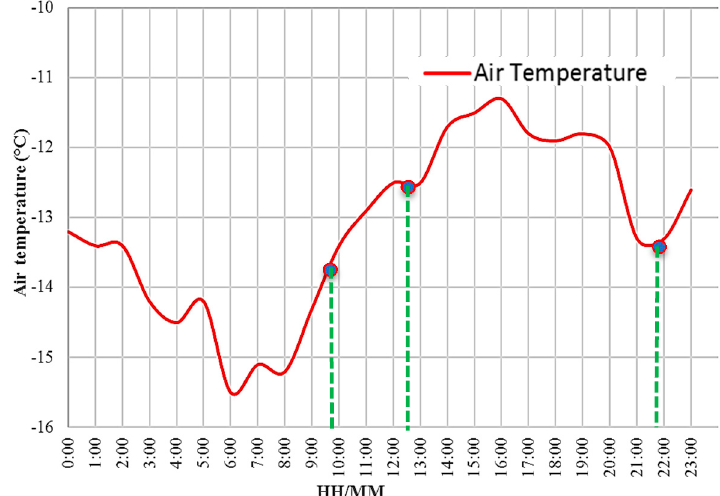
Figure 2. Hourly air temperature measured on 19 May 2012, from the on-ice micro-meteorological station. Colored dots represent times of in-situ snow property measurements at ~9:45 a.m. (for 14 cm), ~12:25 p.m. (for 4 cm) and ~9:30 p.m. (for 8 cm) local times. Green vertical lines denote the timing of